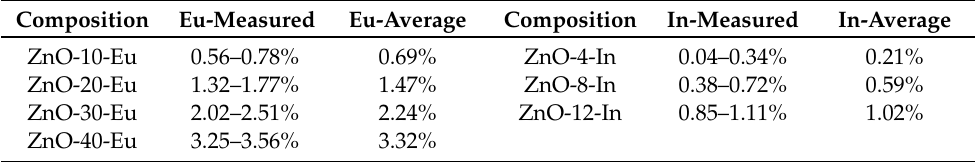
Table 1. Energy dispersive X-ray spectroscopy (EDX) analyses for elemental Zn and Eu or Zn and In. Eu(In)-measured: the range of the measured elemental ratio; Eu(In)-average: the average value of the measured elemental ratio.